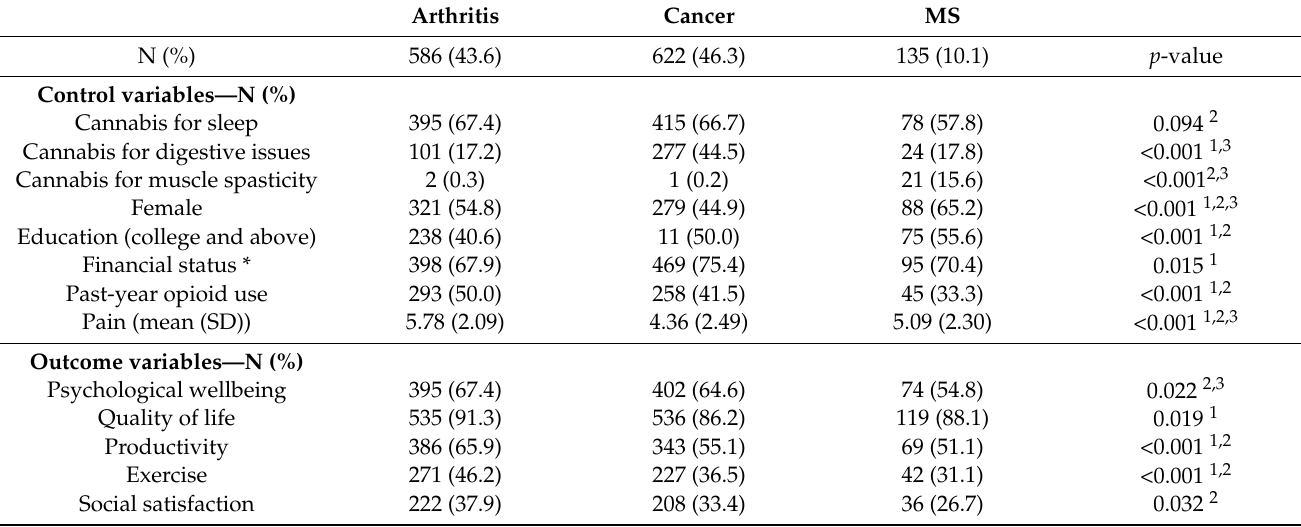
Table 1. Characteristics of respondents with arthritis, cancer, and MS.